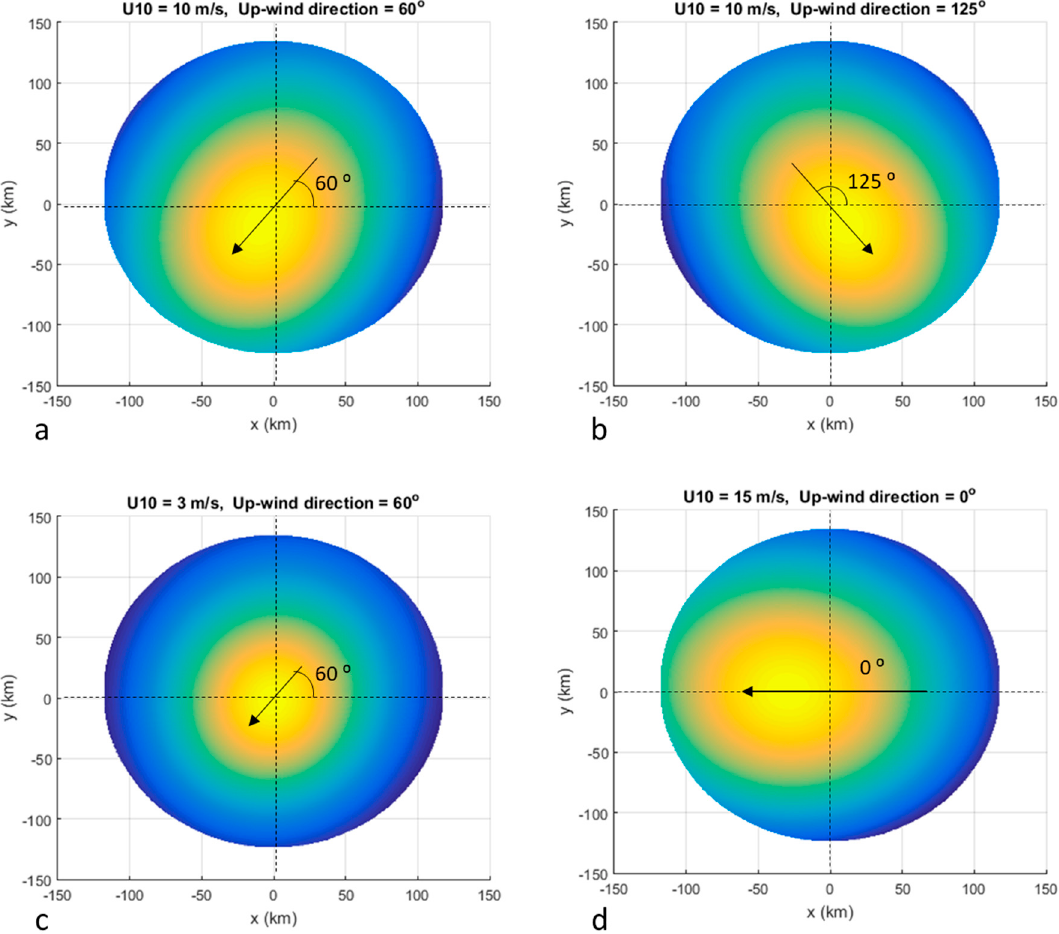
Figure 1. Scattering coefficients over the glistening zone with various wind speed and direction: ( a ) 10 m/s with 60°, ( b ) 10 m/s with 125°, ( c ) 3 m/s with 60°, and ( d ) 15 m/s with 0°.